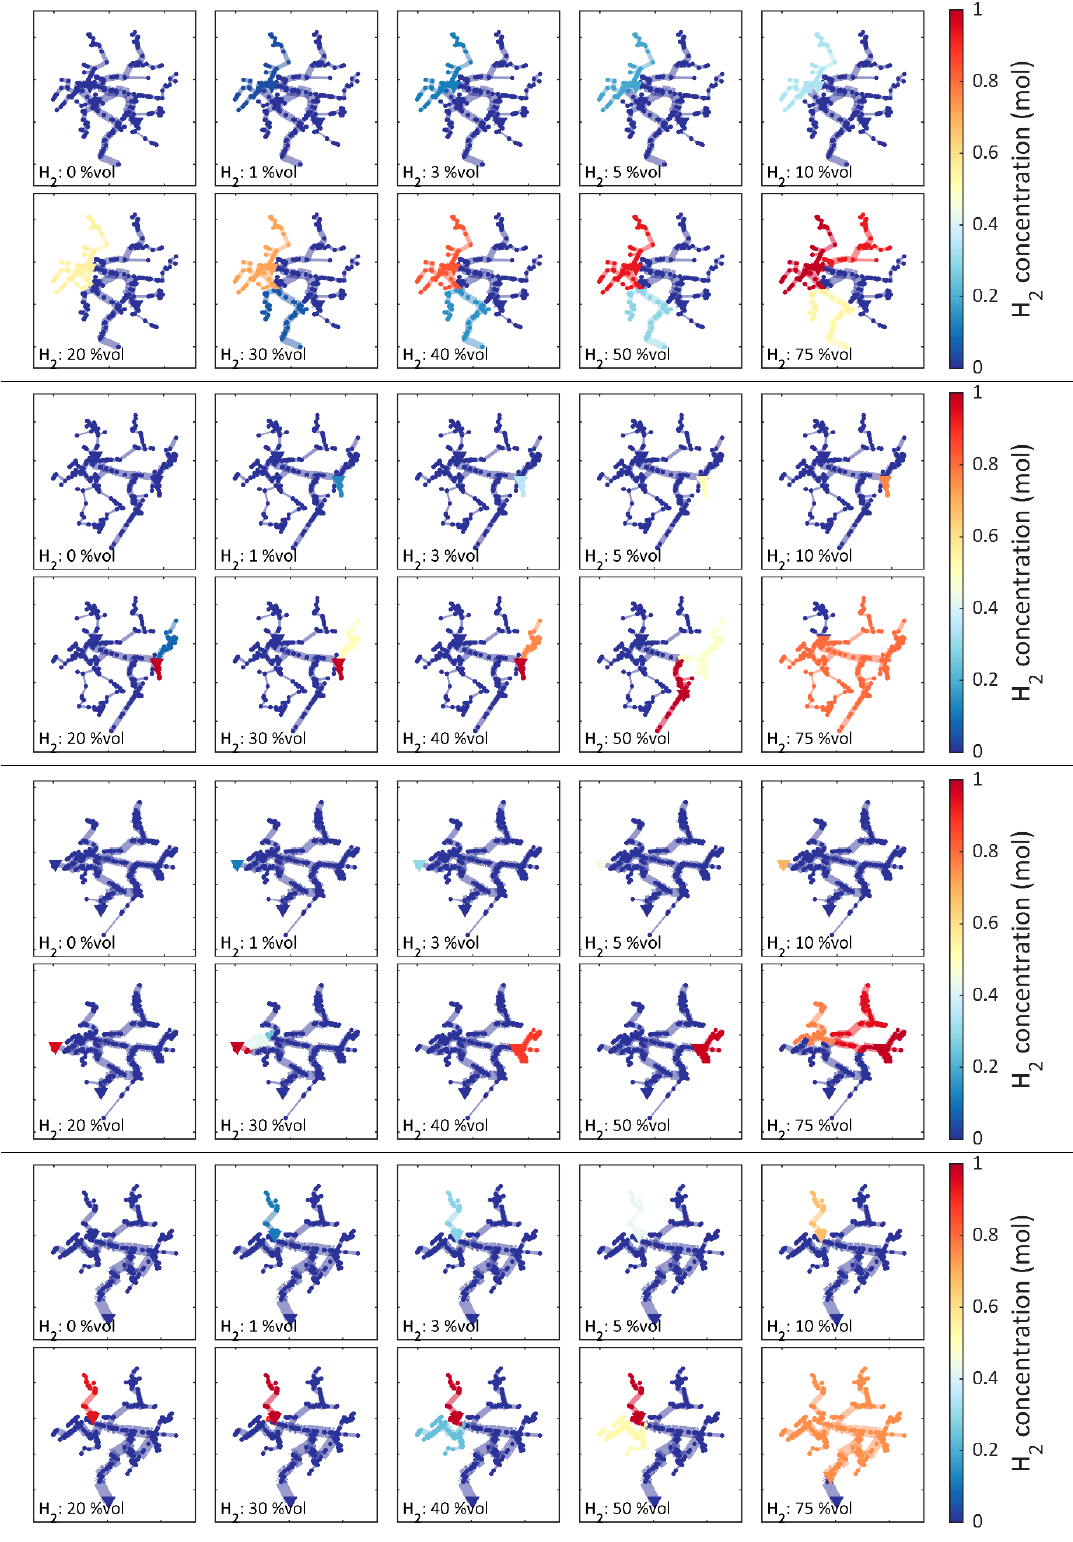
Figure 6. Tracking of gas quality for four sample networks featuring increasing levels of H 2 injections—pure H 2 is injected within the network. Triangles represent nodes of gas supply (NG or H 2 ). Triangles in the same charts of Figure 6 indicate points of gas supply. The triangles on the left-hand side (blue color) constitute NG city gates. The remaining triangles